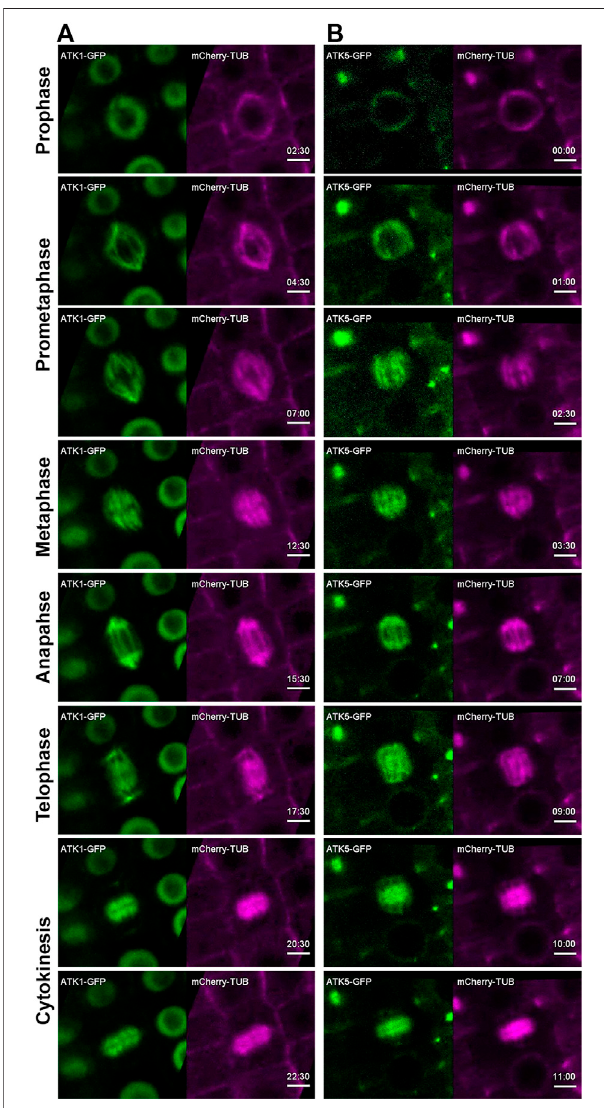
FIGURE 2 | ATK1-GFP and ATK5-GFP associate with spindle MTs in A . thaliana . Time stamps are in min: sec. (A) Snapshots of time-lapse movie of a mitoticcellexpressingATK1-GFPandmCherry-TUB6(forMTs).ATK1-GFPis a nuclear protein prior to nuclear envelope breakdown (2:30). After prophase,theATK1-GFPsignallargelyoverlapswiththatofMTsinthespindle apparatusatprometaphase(4:30and7:00),metaphase(7:30),andanaphase (15:30). ATK1-GFP and MTs also colocalize in the developing phragmoplast at telophase (17:30) and cytokinesis (20:30 and 22:30). (B) In contrast to ATK1 as a nuclear protein prior to nuclear envelope breakdown, ATK5-GFP continuously decorates mitotic MT arrays uniformly from prophase (00:00) to prometaphase (1:00 and 2:30), metaphase (3:30), and anaphase (7:00). ATK5-GFP also decorates the phragmoplast MT array (9:00-11:00). Scale bars, 5